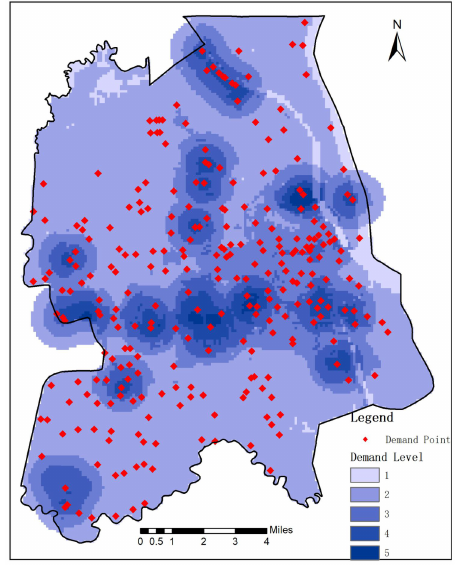
Figure 12. Demand distribution